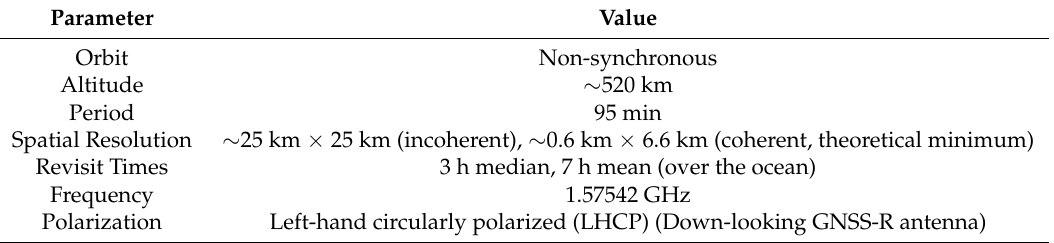
Table 1. Orbital and instrumental specifications of CYGNSS